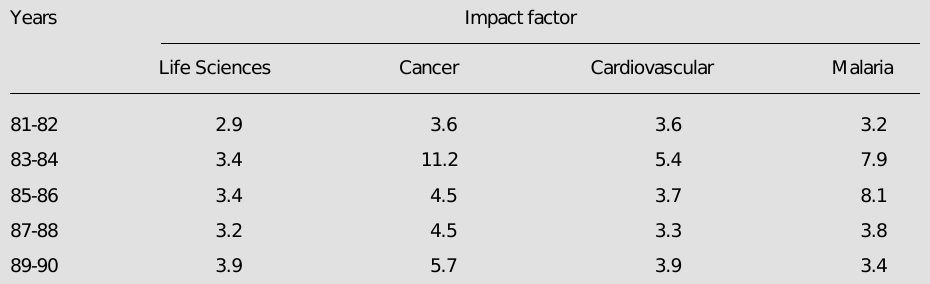
Table 4 - Impact factor calculated by counting citations received by articles during the 5 years following their publication and dividing citations by the respective numbers of papers published in the same period. The year column indicates the time of article